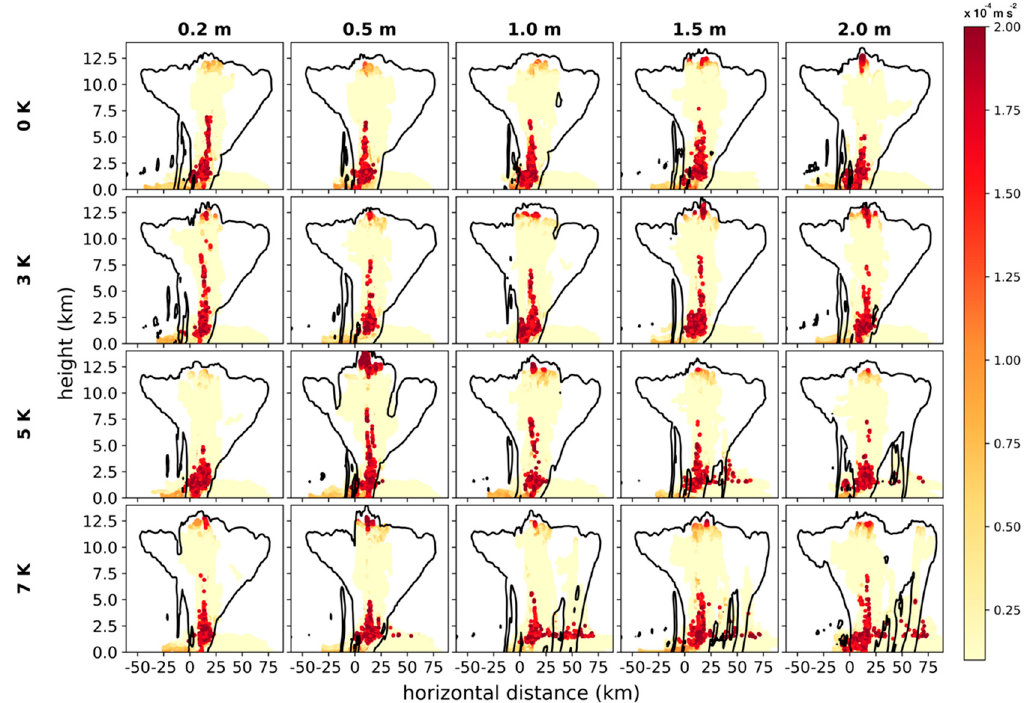
Figure 14. Same as Figure 11, except the parcel location is shaded by the vertical perturbation pressure gradient force.